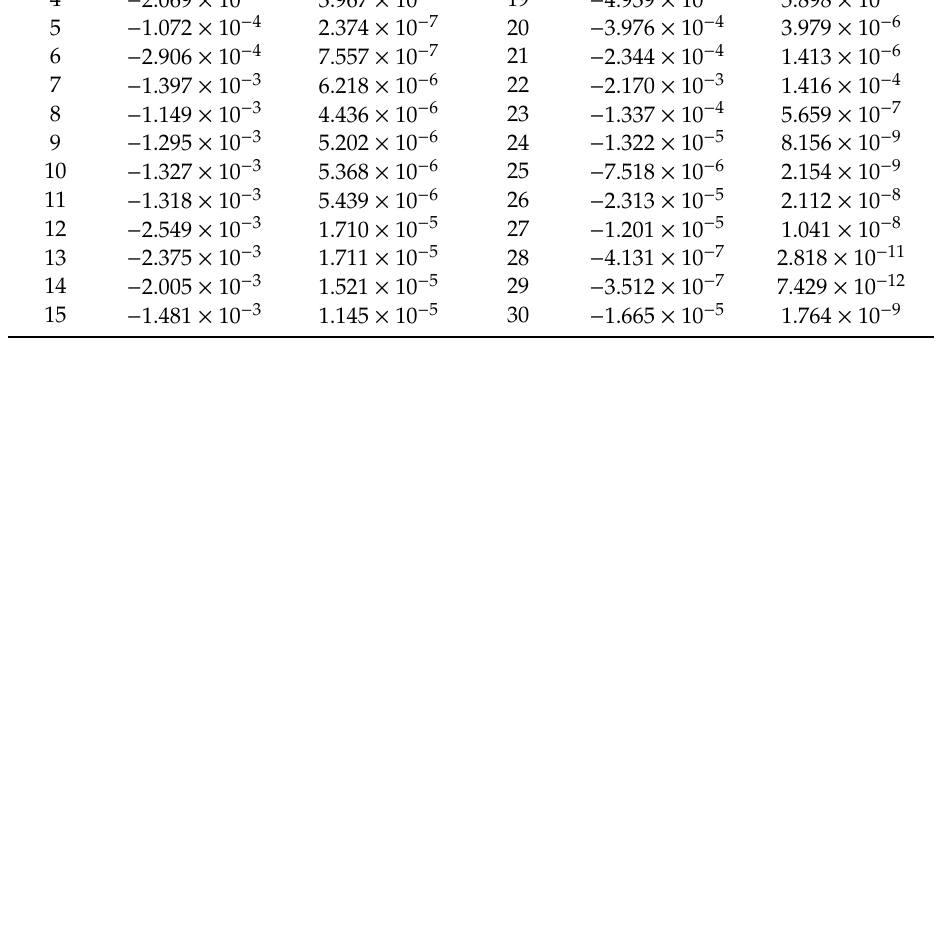
Table 8. Comparison of 1st-order relative sensitivities and 2nd-order relative sensitivities 4 ( 71 Ga).